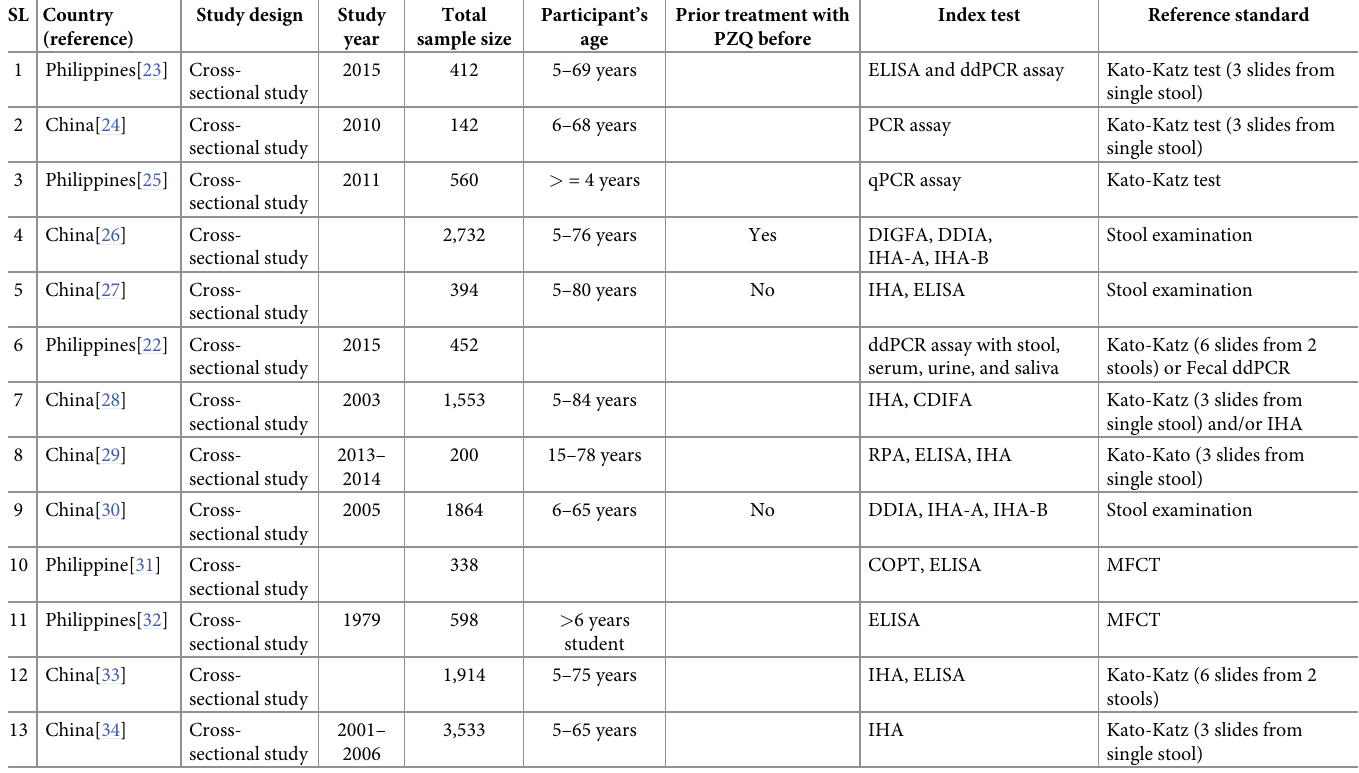
Table 1. Characteristics of studies included in meta-analysis for S . japonicum .